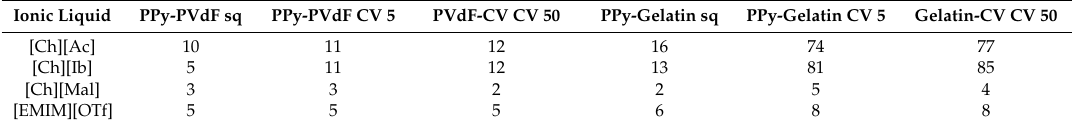
Table 4. The charge-e ffi ciency of the tested actuators (% · Coulomb − 1 · cm 2 ), defined as the